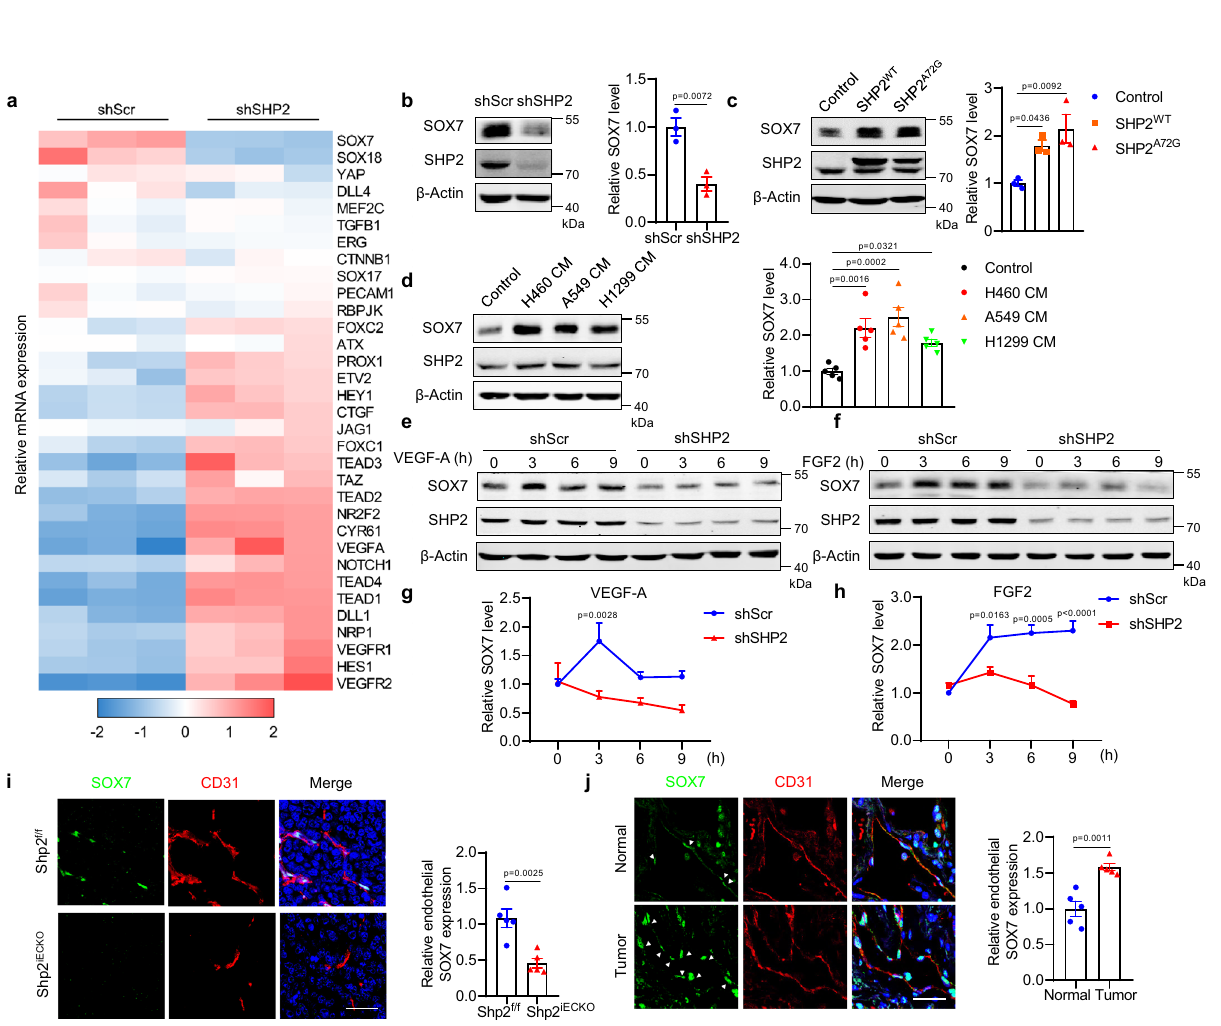
Fig. 4 SHP2 regulates SOX7 expression. a Heatmap showing qPCR results of angiogenesis-related genes in SHP2 knockdown (shSHP2) and control (shScr) HUVECs. b Western blot for SOX7 expression in SHP2-knockdown and control HUVECs. β -Actin was used as a loading control. Quantitative data were shown as mean ± SEM for three independent experiments. p -value was shown and generated by using the two-tailed Student ’ s t -test. c Western blot for SOX7 in overexpression of SHP2 or its A72G active mutation and control HUVECs. β -Actin was used as a loading control. Quantitative data were shown as mean ± SEM for three independent experiments. p -values were shown and generated by one-way ANOVA with multi-comparisons. d Western blot for SOX7 in HUVECs treated with various NSCLC cancer cell-conditioned media for 24 h. β -Actin was used as a loading control. Quantitative data were shown as mean ± SEM for fi ve independent experiments. p -values were shown and generated by one-way ANOVA with multi-comparisons. e – h Western blot for SOX7 expression in SHP2 knockdown and control HUVECs treated with VEGF-A (10 ng/ml) or FGF2 (10 ng/ml) for indicated time. β -Actin was used as a loading control. Quantitative data were shown as mean ± SEM for three independent experiments. p -values were shown and generated by two- way ANOVA with Bonferroni ’ s multiple comparisons test. i Representative images showing SOX7 expression (green) in CD31 + vessels (red) in LLC tumors from Shp2 f/f ( n = 5) and Shp2 iECKO ( n = 5) mice. Endothelial SOX7 was analyzed by the Image J software and quantitative data were shown as mean ± SEM. p -value was shown and generated by using the two-tailed Student ’ s t -test. Scale bar: 100 μ m. j Representative images showing SOX7 expression (green) in CD31 + vessels (red) in NSCLC tumor tissues and paired adjacent normal tissues ( n = 5). SOX7 expression in endothelial cells was analyzed by the Image J software and quantitative data were shown as mean ± SEM. p -value was shown and generated by using the two-tailed Student ’ s t -test. Scale bar: 100 μ m. Source data are provided as a Source data fi